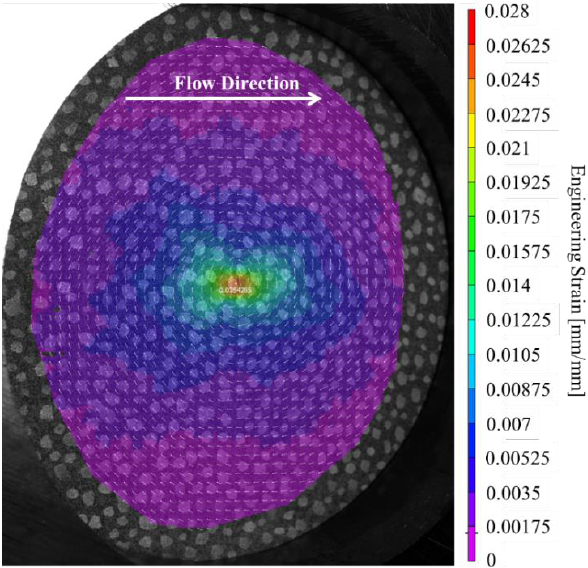
Figure 13. 1st principal (engineering) strain from DIC for quasi-static specimen #1.